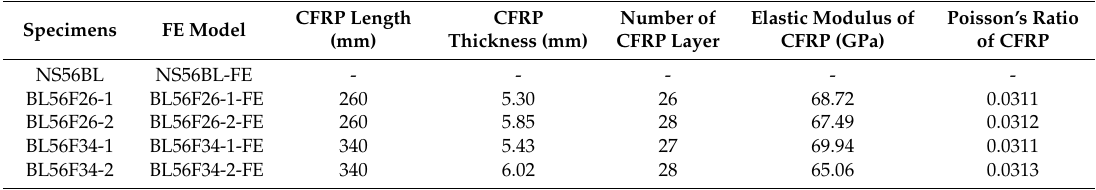
Table 1. Specimen matrix.